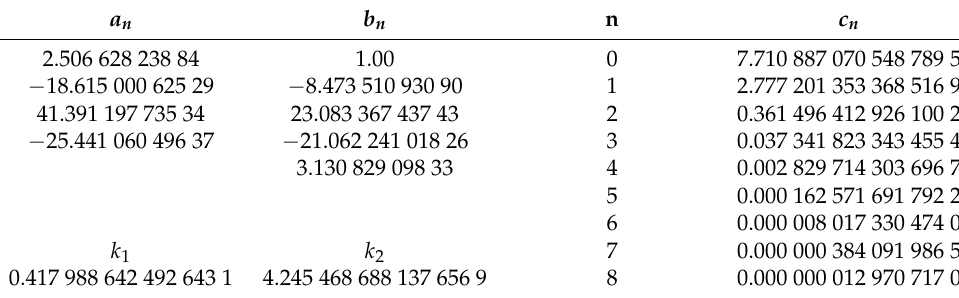
Table A1. The specific parameter settings of Moro